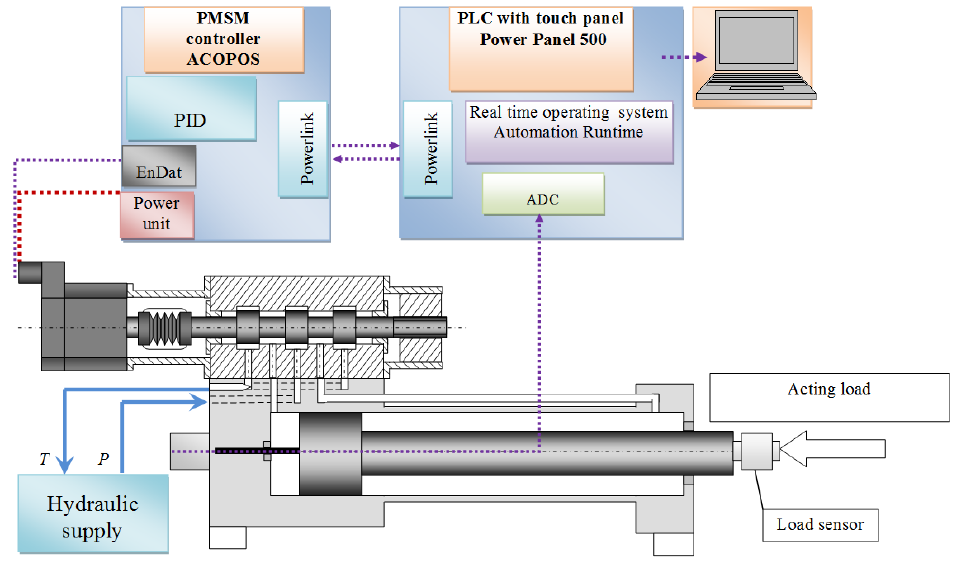
Figure 11. Control stand for performing servo drive test.